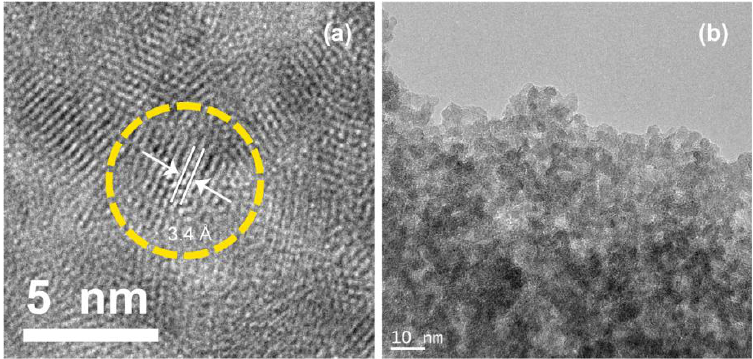
Figure 1. High resolution-transmission electron microscopy (HR-TEM) images of the ZnS:Mn-Asp nanocrystals (NCs). Asp: L-aspartic acid.